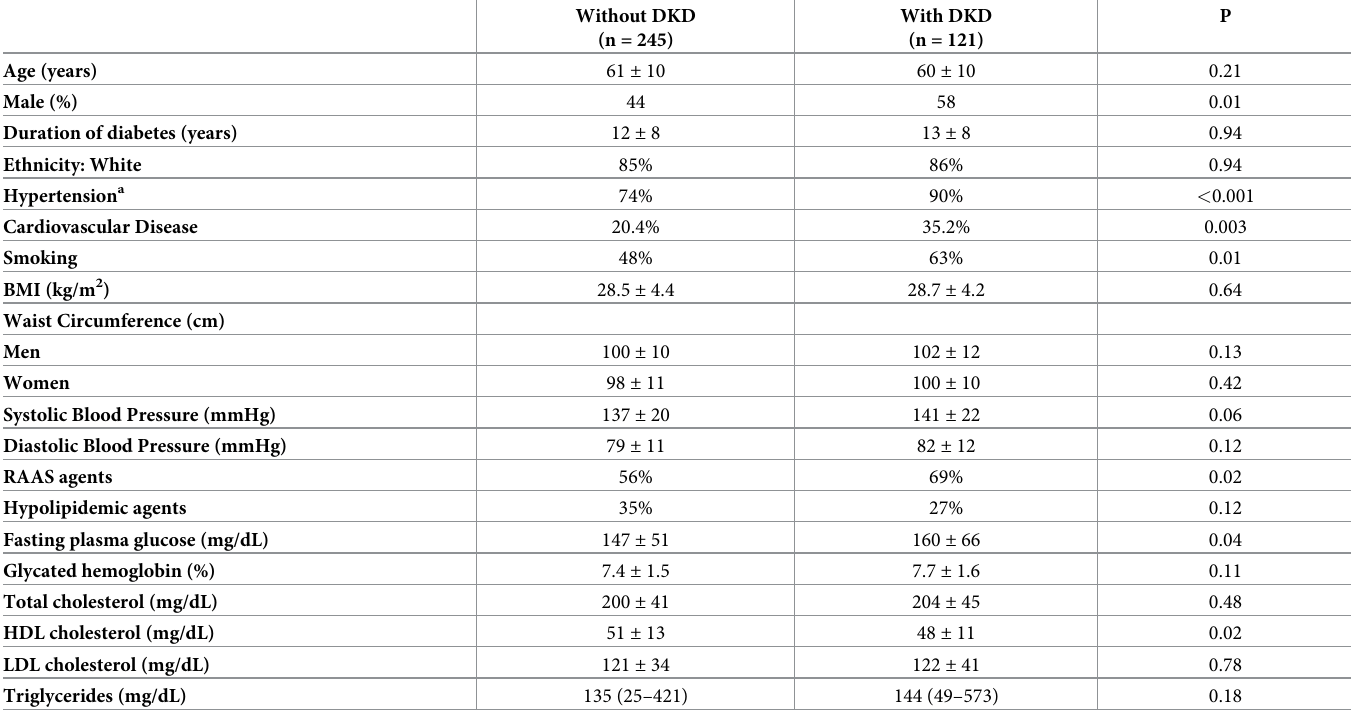
Table 1. Clinical and laboratory characteristics of patients with type 2 diabetes divided according to the presence or not of diabetic kidney